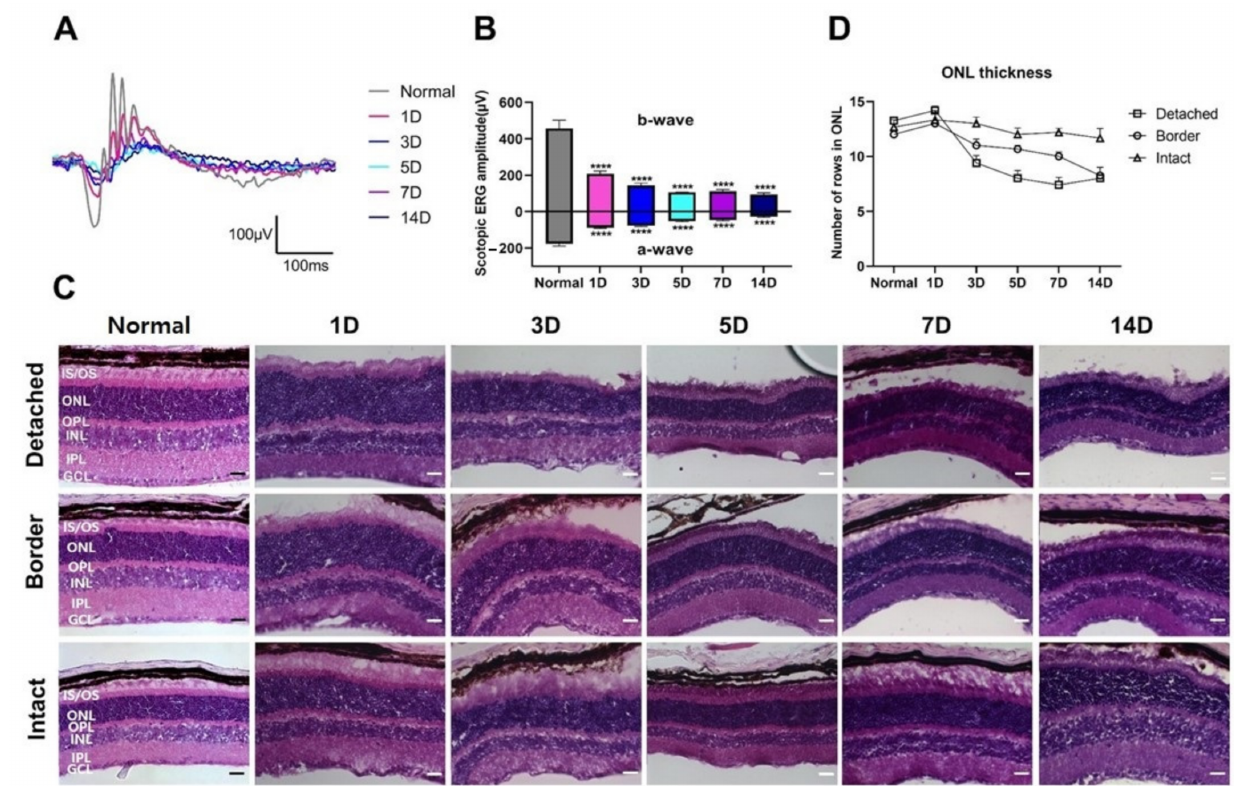
Figure 1. Functional and histological evaluation of retinal detachment (RD) at different time points. Electroretinograms (ERGs) were recorded in RD mice. ( A ) Representative scotopic ERG responses in normal (gray) and RD mice after 1 (pink), 3 (blue), 5 (cyan), 7 (purple), and 14 days (navy). Based on the functional changes, the amplitudes of both scotopic a- and b-waves significantly reduced in a time-dependent manner, compared to those in the normal group. ( B ) Values are represented as the mean ± SEM ( n = 5, p < 0.001, one-way ANOVA). ( C ) Hematoxylin and eosin (H&E) staining of representative vertical sections from normal control and the detached retina at different time points (1, 3, 5, 7, and 14 days). Retinal thickness of the outer nuclear layer (ONL), where the photoreceptor residue gradually decreased. Scale bars, 20 µ m. ( D ) ONL thickness was measured manually at each time point. According to histological changes in the detached region, ONL thickness significantly reduced in a time-dependent manner, and no significant changes were observed in the intact region. IS/OS, inner segment and outer segment; OPL, outer plexiform layer; INL, inner nuclear layer; IPL, inner plexiform layer; GCL, ganglion cell